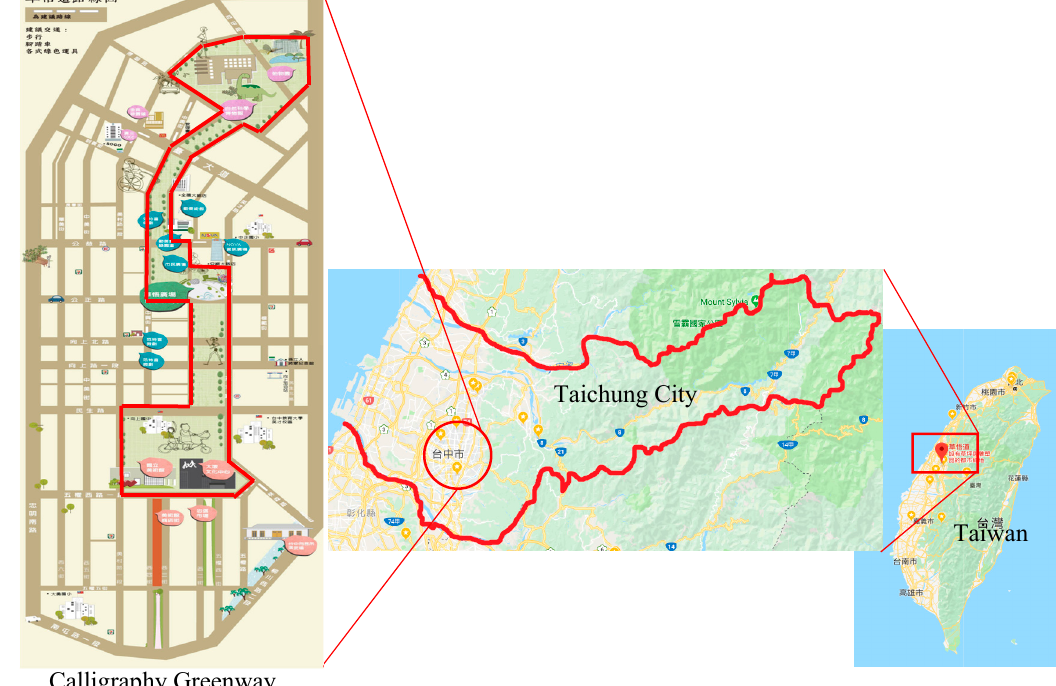
Figure 2. Geographic l ocation of the Calligraphy Greenway.